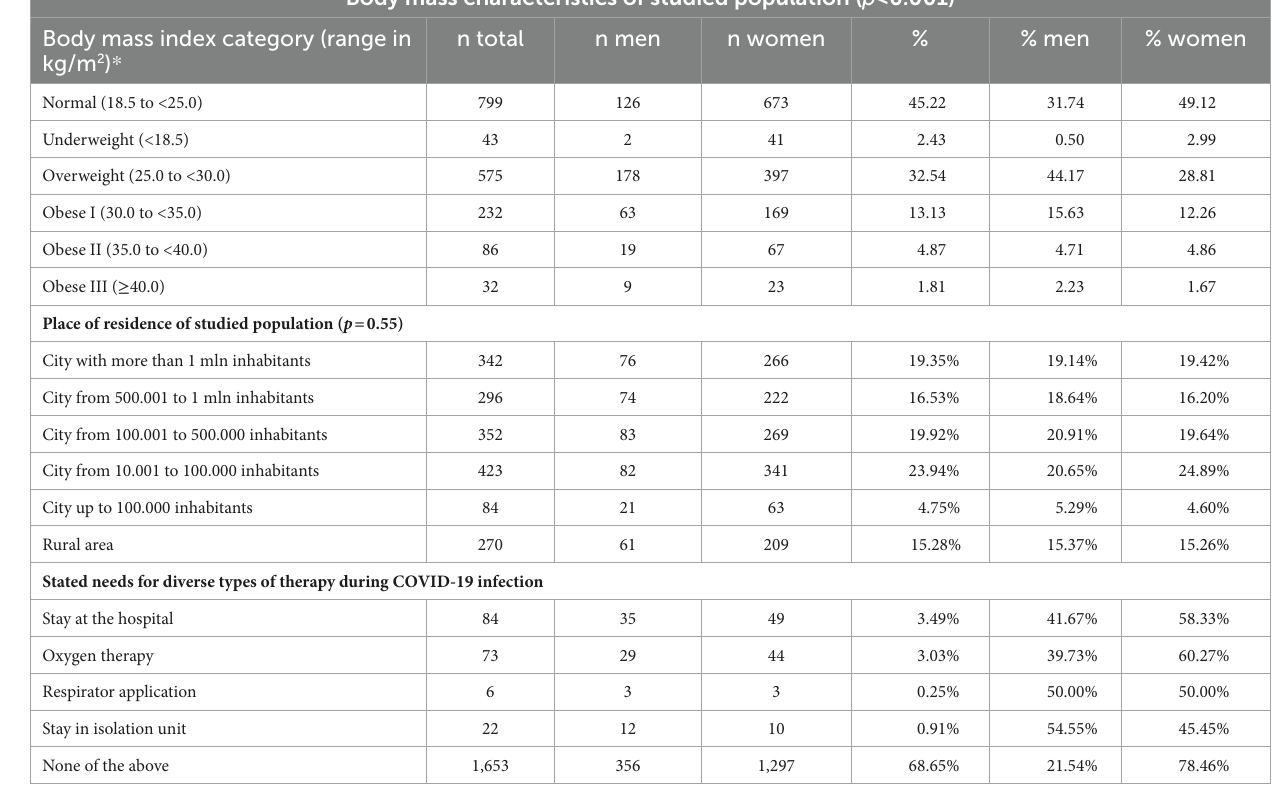
TABLE 2 Body mass, place of residence, and needs of therapy among studied population. Body mass characteristics of studied population ( p <